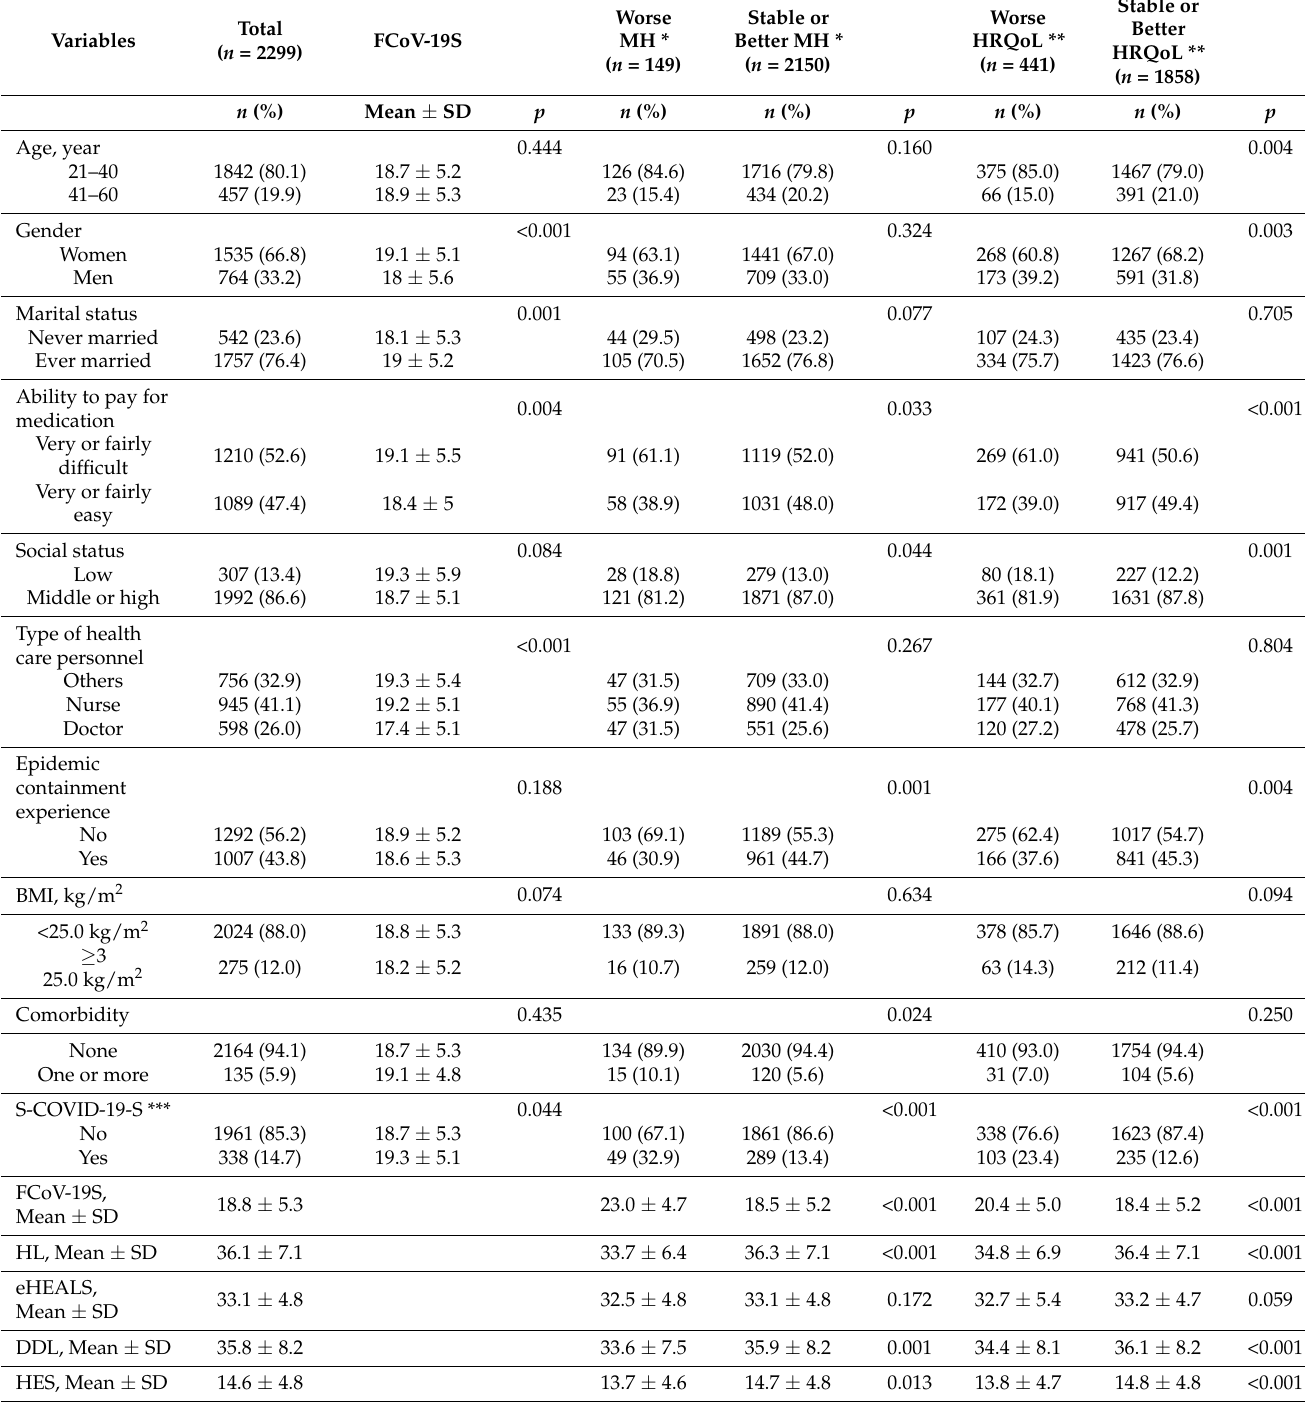
Table 1. Characteristics, fear of COVID-19, changes in mental health, and health-related quality of life among front-line health care